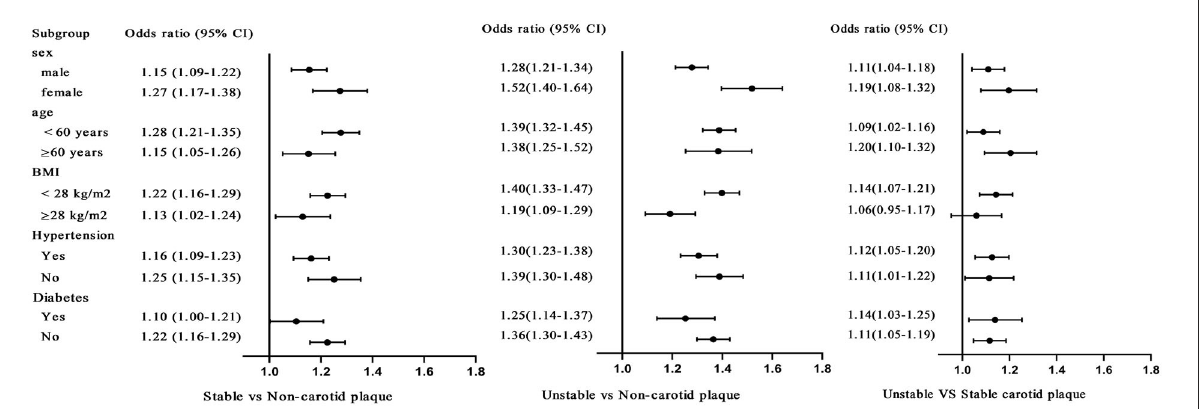
FIGURE2 Subgroup analysis was conducted by stratification according to sex, age, BMI, hypertension, and diabetes, when the non-HDL-C/HDL-C ratio was considered as a continuous variable. After the fully adjustment, the same variables as Model 3 in Table 2, the odds ratios ( ORs ; 95% CIs ) of the non-HDL-C/HDL-C ratio and carotid stability.